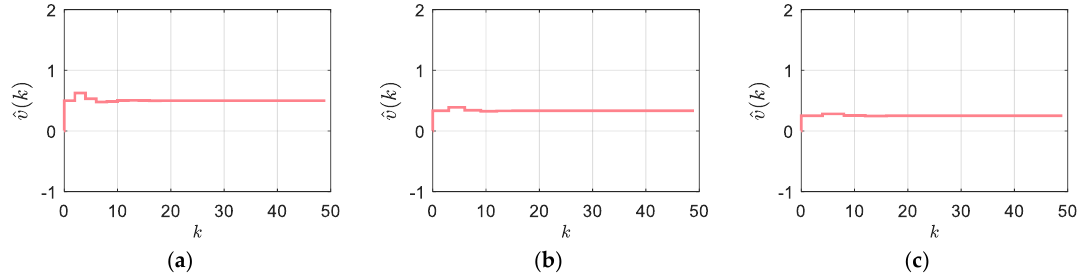
Figure 5. Step response of the GDLMT filter in the case of blank sampling intervals (constant δt k / T s = 0.5): ( a ) n i = 1; ( b ) n i = 2; ( c ) n i = 3.